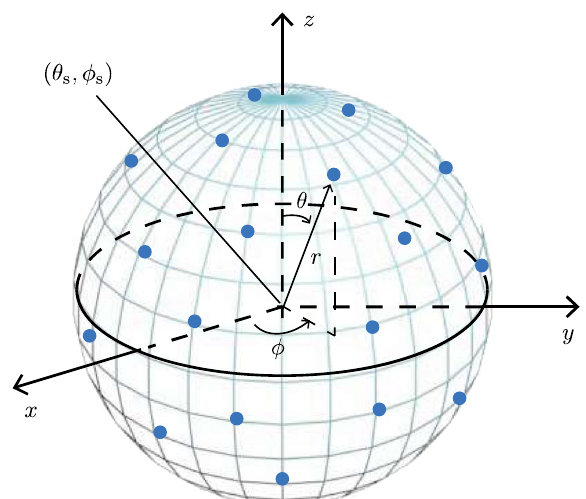
Fig. 2 Geometric model of a spherical